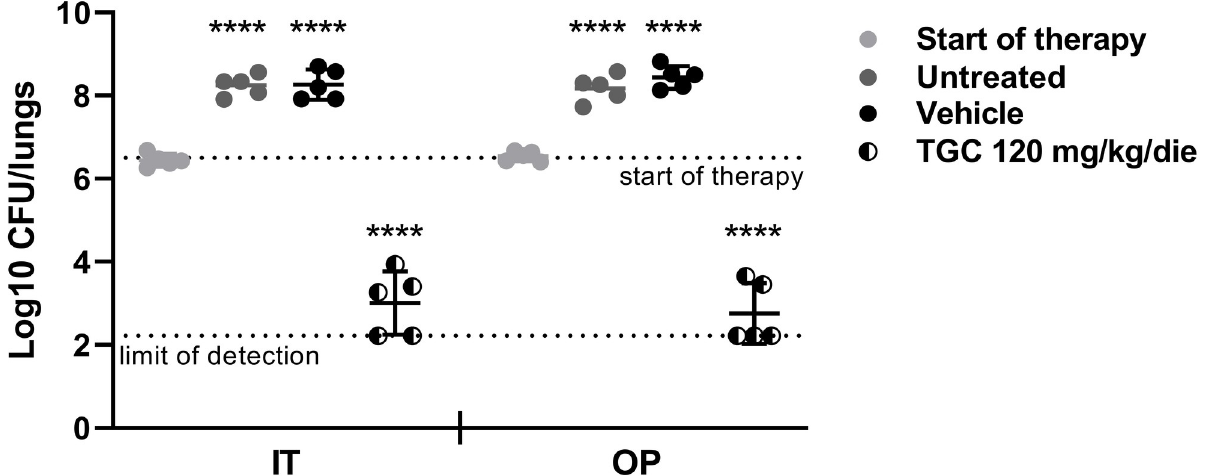
Fig 2. Bacterial load in lung of immunocompromised mice infected with A . baumanii ACC001 during therapy with TGC. Bacterial counts in lungs of animals intratracheally (IT) and oropharyngeally (OP) infected with MDR A . baumannii ACC001 (challenge 5.77 Log10 CFU/mouse) untreated (T0) and treated with vehicle (VEH) or tigecycline (TGC) 120 mg/kg/day (T24). Data expressed as scatterplot distribution (included mean). Statistical analysis was performed by a Two Way ANOVA followed by Tukey’s Multiple Comparison Test, ���� p < 0.0001 (VEH and TGC vs start of